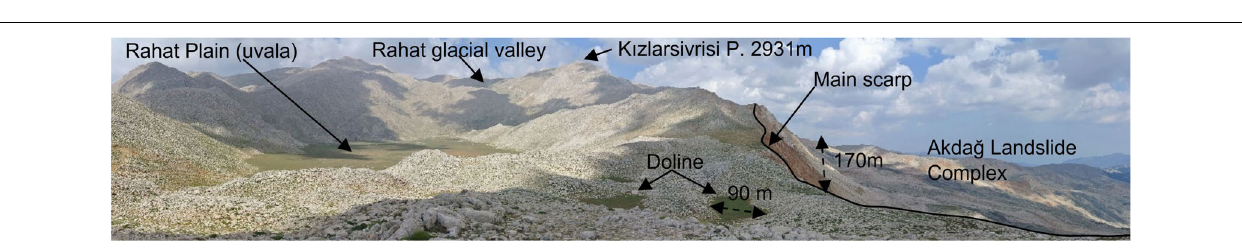
FIGURE 10 | (A) Distribution and depth of karstic depressions (TWI: topographic wetness index). (B, C) Head of a karstic spring on the eastern flank of the Akdag rock avalanche (In Figure 4 , viewpoints of photographs are marked).